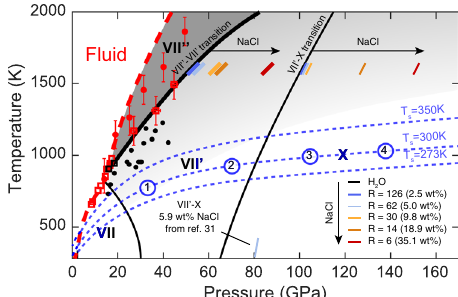
Fig. 3 Phase diagram of bcc water ices. Solid-solid phase boundaries in pure ice are indicated by black lines. Corresponding phase boundaries in NaCl-bearing ice (NaCl· R H 2 O) ice are shown at 1600 K and 300 K. Grey areas indicate where pure H 2 O is superionic, with darker areas corresponds to regions with higher H-diffusion coef fi cients. The phase boundaries in pure H 2 O ice are drawn based on our DFT-MD simulations 19,24 and on both experimental 64 and theoretical works 18,65 that take into account quantum effects at 300 K. The melting line of pure ice as obtained in our single- phase simulations is shown by the red dashed line. Experimental melting points from Schwager et al. 66 . and Queyroux et al. 26 . are shown as red circles and red empty squares respectively. Black empty squares correspond to the experimental determination of fi rst-order transition between superionic ice VII ″ and ice VII ′ 26 , and black dots refer to a solid- solid transition 66 , likely corresponding to the same transition. Blue dashed lines show adiabatic pro fi les in the H 2 O layer of hypothetical ocean exoplanets with habitable pressure-temperature conditions in the surface ocean and no or thin atmosphere (see Supplementary Information). The different pro fi les are anchored at surface temperatures of 273 K (temperature of crystallization of pure ice Ih), 300 K and 350 K (representative temperature for an optimal growth of thermophile and hyperthermophile organisms 67 ) respectively. Circled numbers 1, 2, 3 and 4 indicate approximate pressures at the bottom of the high-pressure ice mantle for 1, 2, 3, and 4 M (cid:4) planets (i.e., ∼ 1.3, 1.5, 1.7, 1.9 R (cid:4) ) with 50 wt% H 2 O and Earth-like cores as calculated in Sotin et al. (2007) for a surface temperature of 300